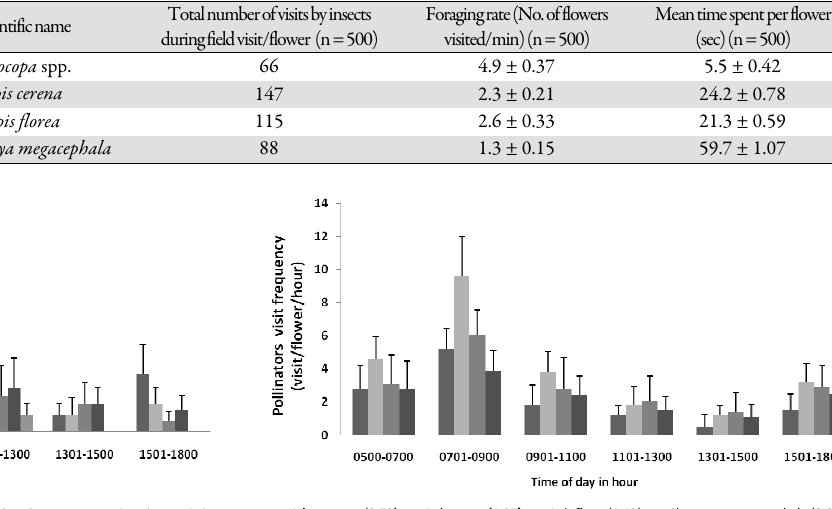
Fig. 5. Frequency of pollinators (bees, butterflies and beetle) visits in respect to the time of day for S. wallichii in the year 2013 (values in parentheses indicate LSD values for 5%)